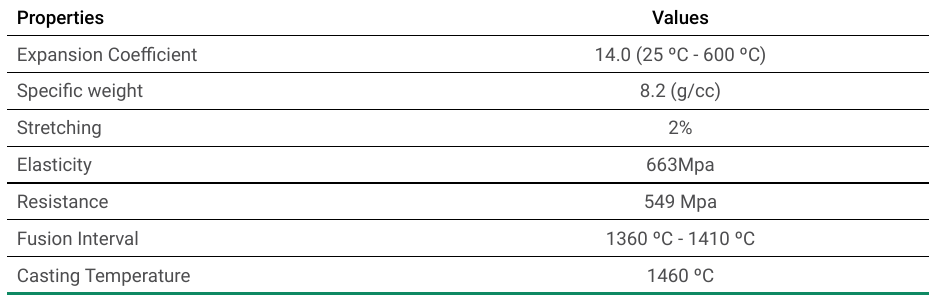
Table 1. Mechanical, physical and thermal properties of the Co-Cr alloy (Fit Cast Talmax) available from the manufacturer.